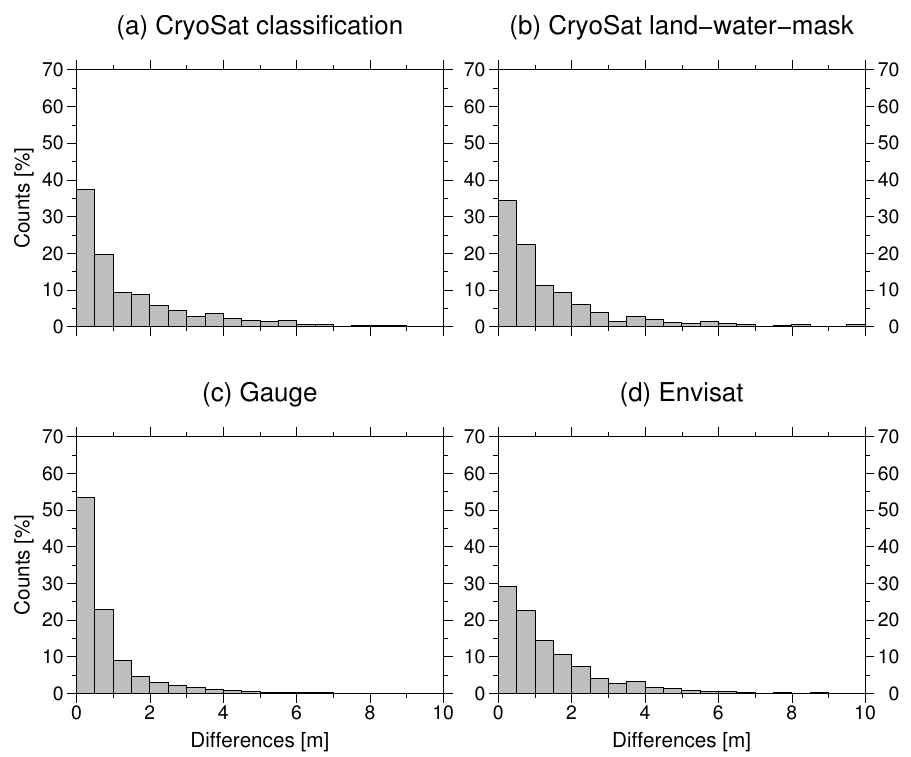
Figure 9. Histogram of the differences of height measurements 369 days apart for CryoSat-2 water levels with classification, CryoSat-2 water levels inside the land–water mask, gauge water level, and Envisat water